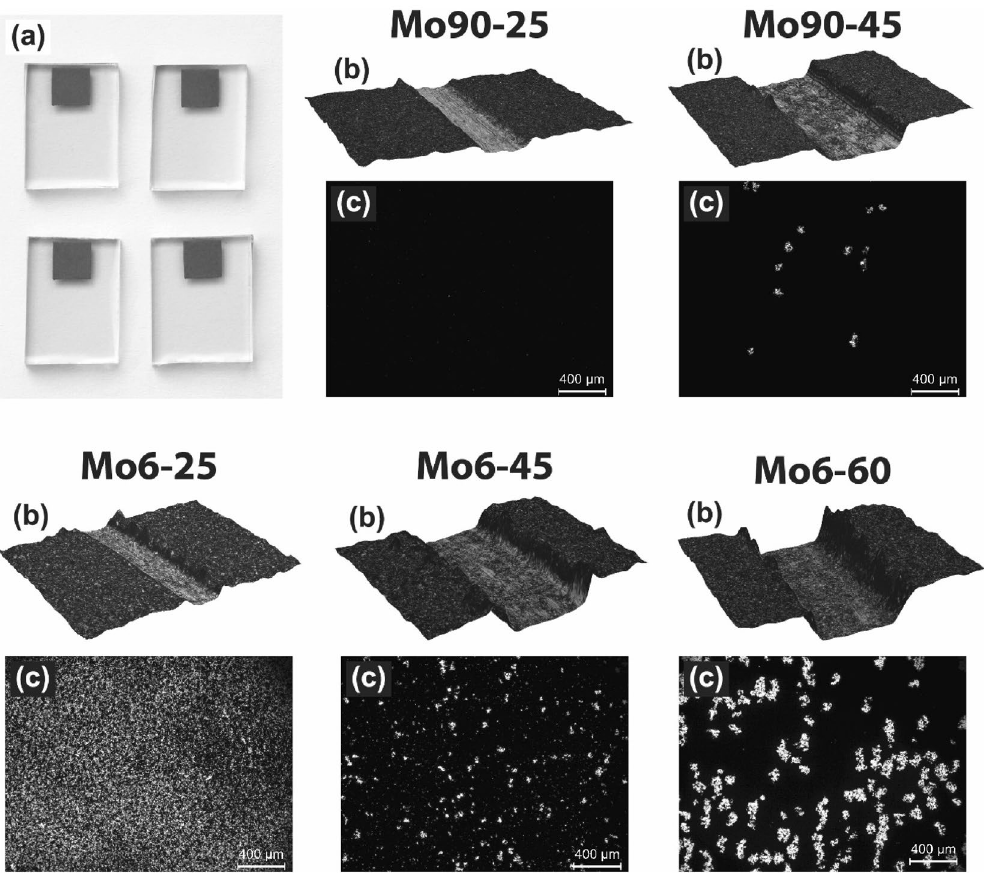
Figure 2. ( a ) Screen-printed MoS 2 layers onto FTO substrates. ( b ) Needle scratch was made through the middle of the MoS 2 layers, and the thickness measurement was evaluated by an optical microscope using the 3D image sequential recording method. ( c ) Optical microscopy images of MoS 2 layers after the peeling test evaluated adhesion to FTO